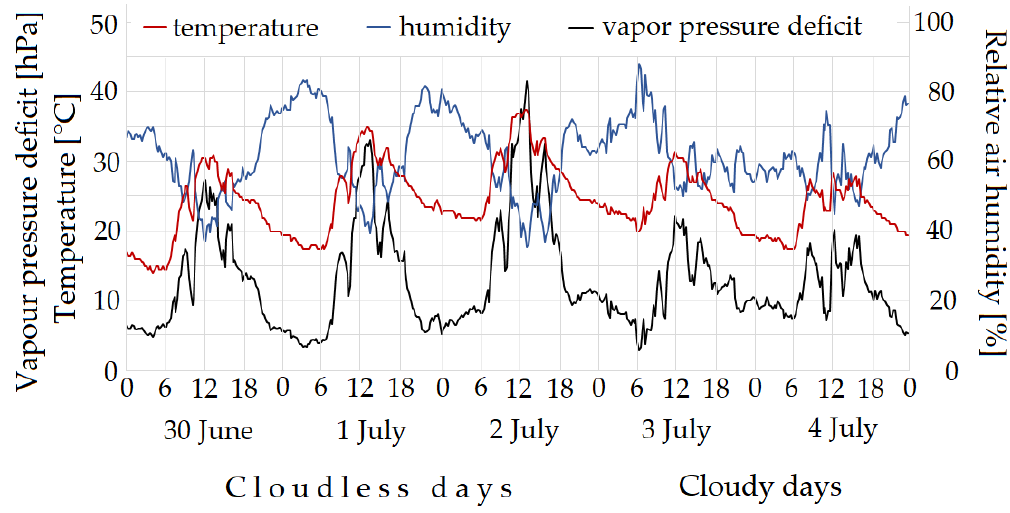
Figure 3. Diurnal courses of air temperature, relative air humidity, and vapor pressure deficits (vpd) on three cloudless days and two cloudy days in the gap of the Maciova transect.